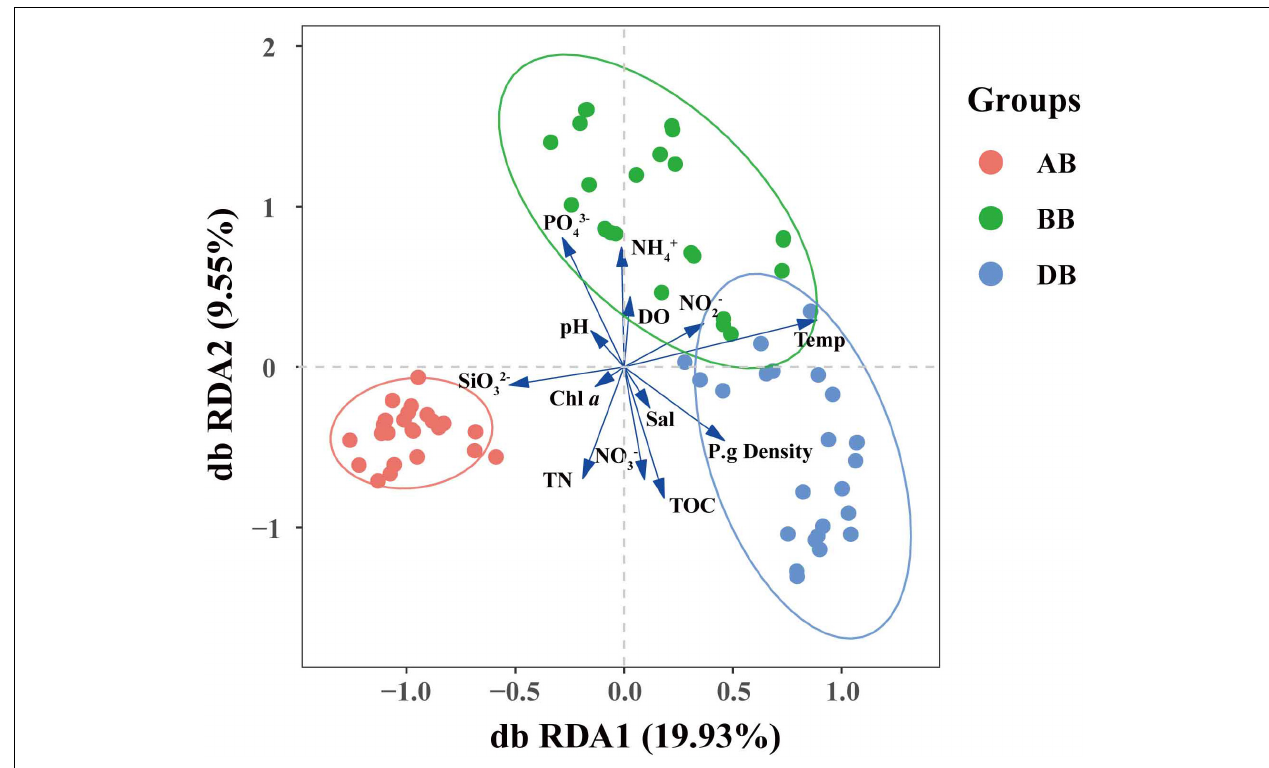
FIGURE 4 | Distance-based redundancy analysis (db RDA) ordination plots of the bacterial community–environment relationships. BB, before P. globosa blooms; DB, during P. globosa blooms; AB, after P. globosa